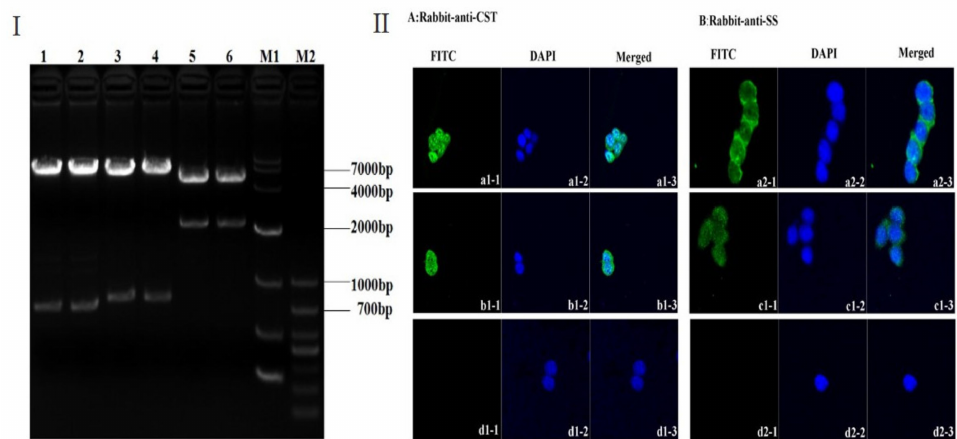
Figure 2. ( I ) Agarose gel electrophoresis of pIRES-S/CST14-S/2SS plasmid digested with restriction endonucleases. Lanes 1 and 2 showed two bands of 717 bp and 6880 bp with Nhe I and EcoR I digestion; Lanes 3 and 4 showed two bands of 789 bp and 6808 bp with Sal I and Not I digestion; and Lanes 5 and 6 showed two bands of 2200 bp and 5397 bp with Nhe I and Not I digestion. ( II ) Confirmation of expression of S/CST14 and S/2SS fusion protein in pIRES-S/CST14-S/2SS (a), pIRES-S/CST14 (b), pIRES-S/2SS (c), and pIRES (d, control) transfected GH3 cells, respectively. Images were captured using a confocal microscope. The S/CST14 fusion protein could be clearly observed in GH3 cells (a1-1, a1-3, b1-1, and b1-3). Also, the S/2SS fusion protein could be clearly observed in GH3 cells (a2-1, a2-3, c1-1, and